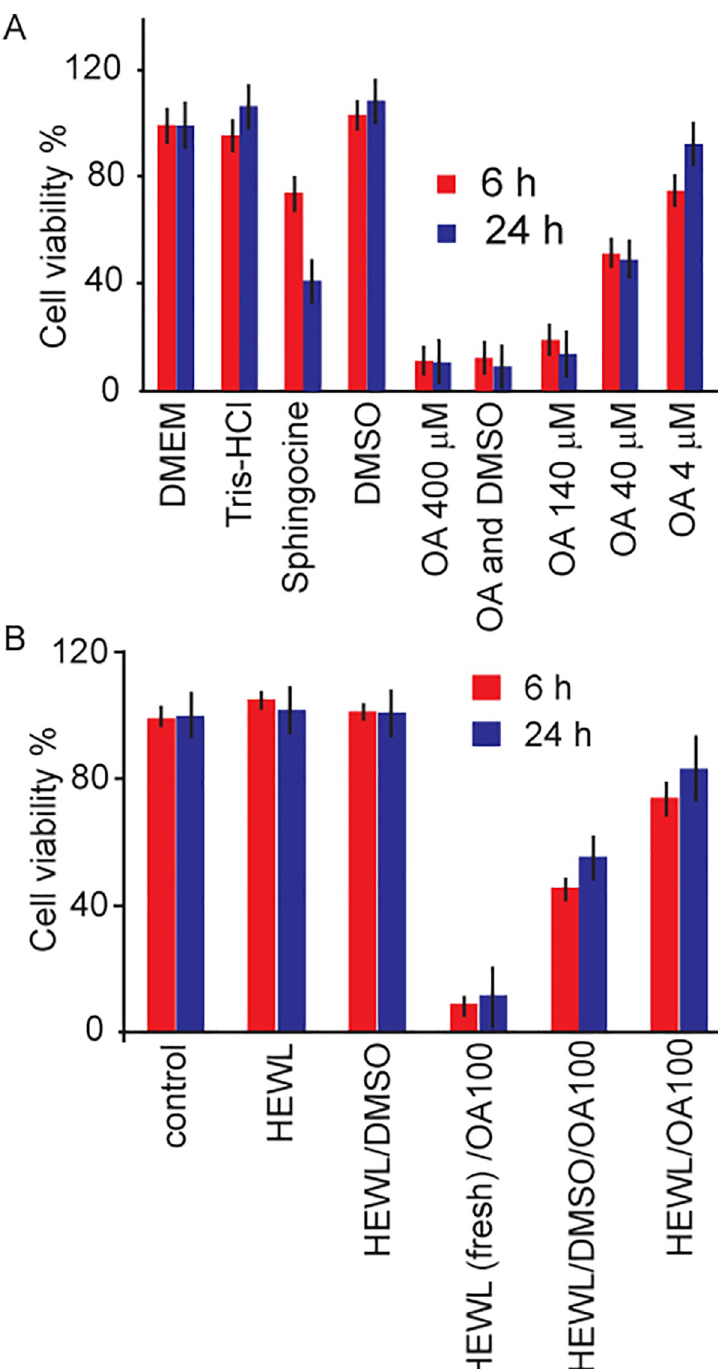
Fig 3. Measurements of SH-SY5Ycell viability by WST-1 assay in the presence of different concentrations of oleic acid (4 to 400 μ M), and (B) HEWL- OA complex. In control experiments the cells were incubated in DMEM cell culture buffer, Tris-HCl buffer, sphingocine and 16 mM DMSO. In DMEM culture medium, cell viability is equal to 100%. In the mixture of OA and DMSO, the OA concentration is 400 μ M and DMSO16 mM. All HEWL samples were prepared at HEWL concentration of 1.4 mM (OA is 14 and 140 mM) and aged 1 d in 20 mM glycine buffer under continuous shaking at800 rpm, pH 2.3 and 57˚C.